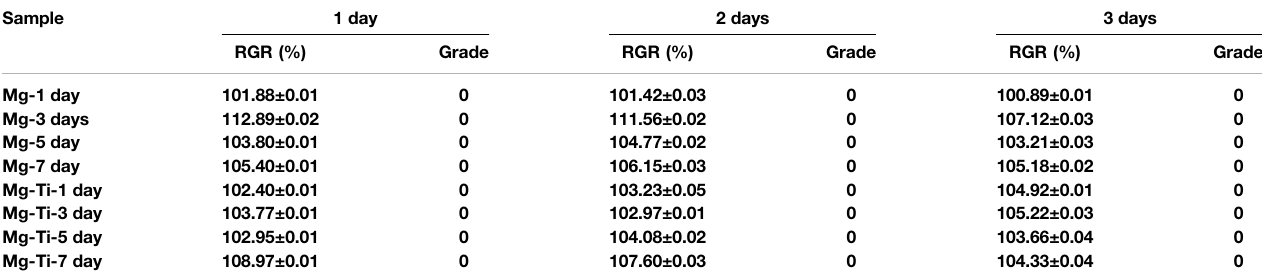
TABLE 1 | Relative growth rate (RGR) and cytotoxicity level of MC3T3-E1 cells cultured with extracts of the degraded Mg-Ti composite and pure Mg at different detection periods. Sample